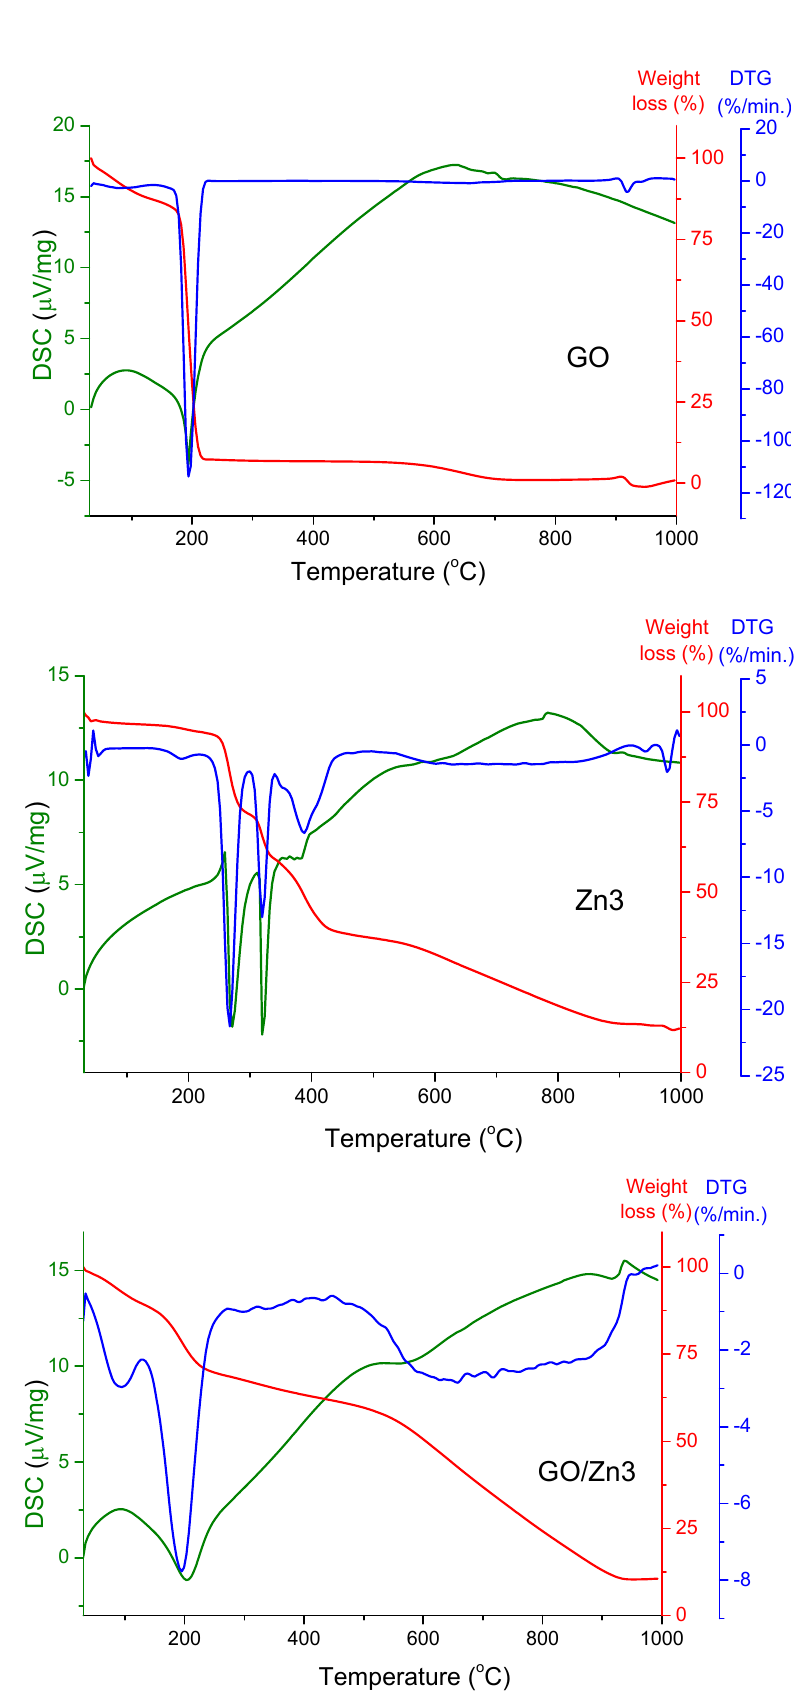
Figure 5. TGA– DTG– DSC thermograms of GO, Zn3 , and Zn3 /GO.